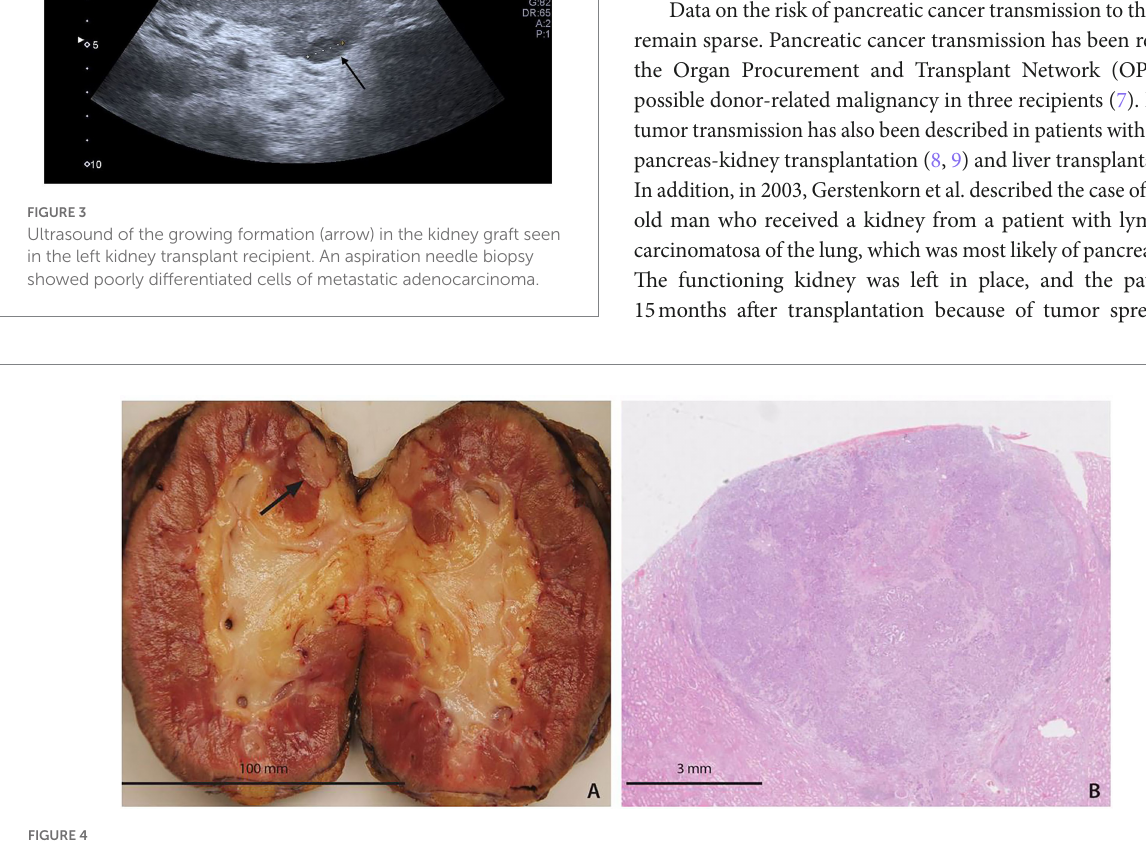
FIGURE 4 Pathological findings in the recipient of the left kidney. (A) Macroscopic view of the adenocarcinoma (arrow). (B) Adenocarcinoma by light microscopy (H&E).